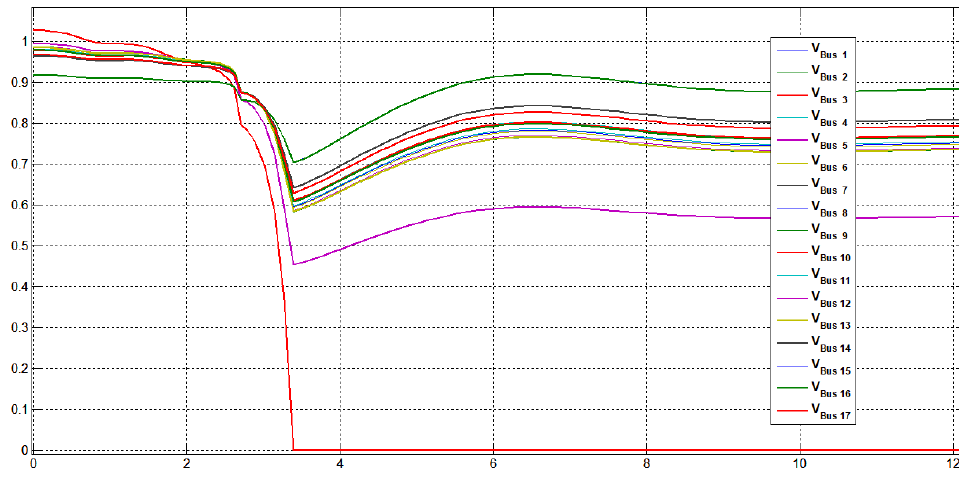
Figure 33. Variation of voltage at all buses after SPVGP disconnection.